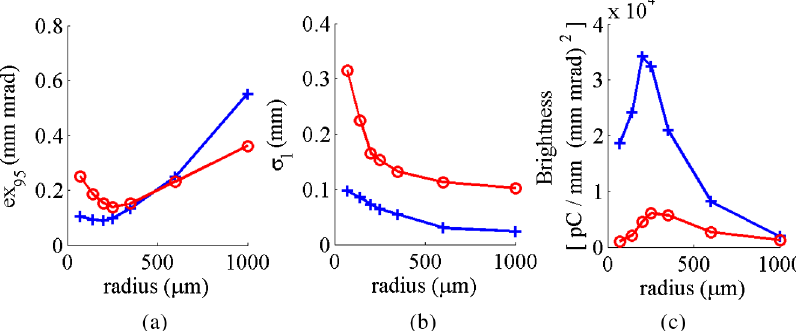
FIG. 8. Results from charge parameter scans as a function of the laser spot size radius for 20 pC bunches where the blue crosses are for X-band ( 200 MV = m cathode field) and the red circles are for S-band ( 120 MV = m cathode field): (a) minimum 95% transverse emittance, (b) minimum bunch length, (c) maximum peak brightness.